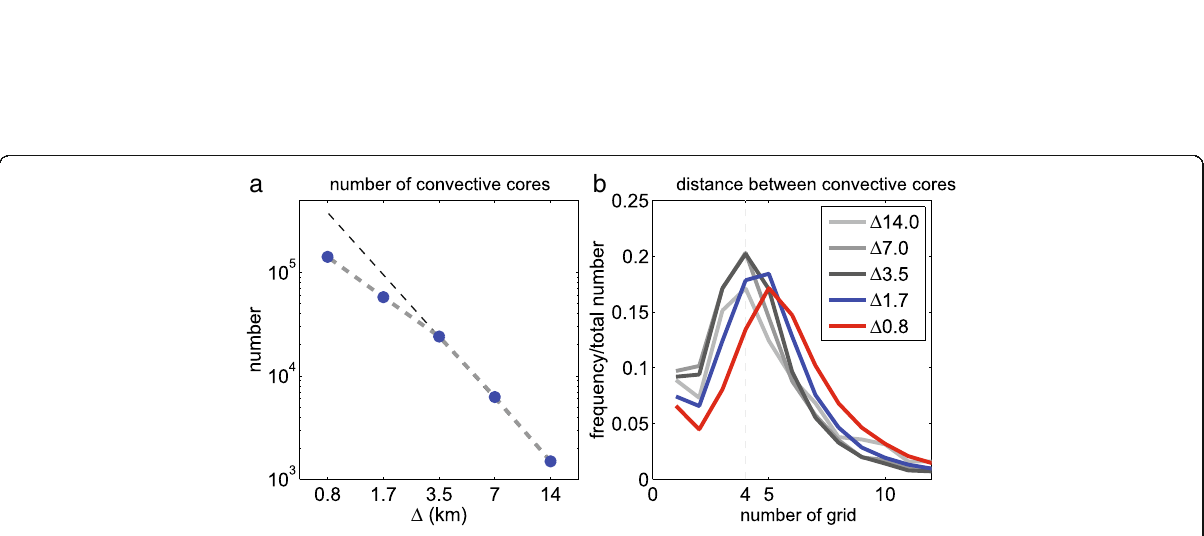
Fig. 4 Resolution dependencies of convective features. a Number of convective cores, and b grid distance to convective cores. The dashed line in ( a ) indicates a log Δ 4 crossing at the point of simulation results with 14 km grid spacing as a reference. After Fig. 4 of Miyamoto et al. (2013)